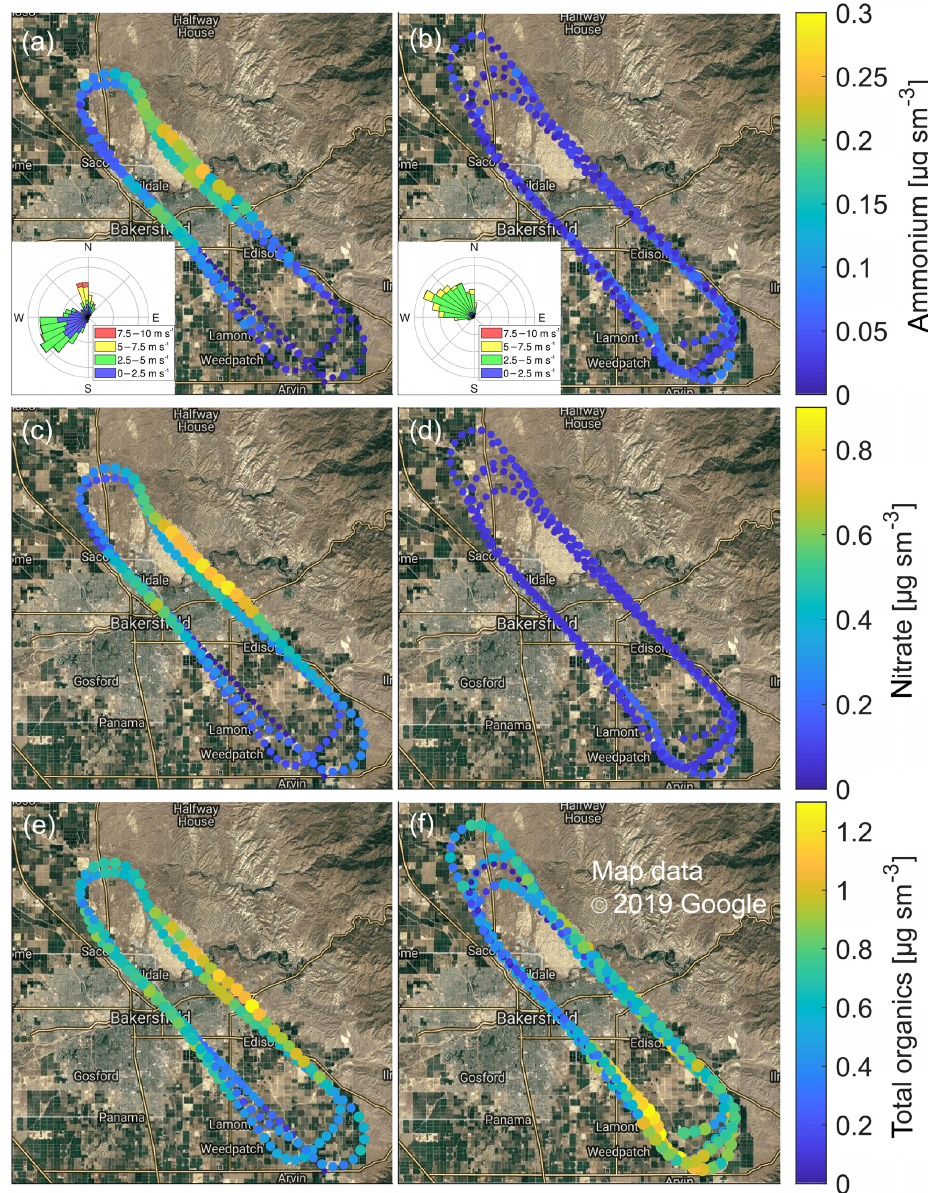
Figure 4. Mass concentrations of ammonium (a, b) , nitrate (c, d) and total organics (e, f) as observed in the boundary layer of the San Joaquin Valley in California. Individual points represent 10s data averages. The data recorded in the late morning (10:48–11:20 local time, 17:48-18:20 UTC) are shown in (a, c, e) . Panels b, d, f refer to the early afternoon (14:02–15:01 local time, 21:02-22:01 UTC) observations. The two inserts in the uppermost panels show that the prevalent wind direction shifted from the SW to the NW between the morning and afternoon